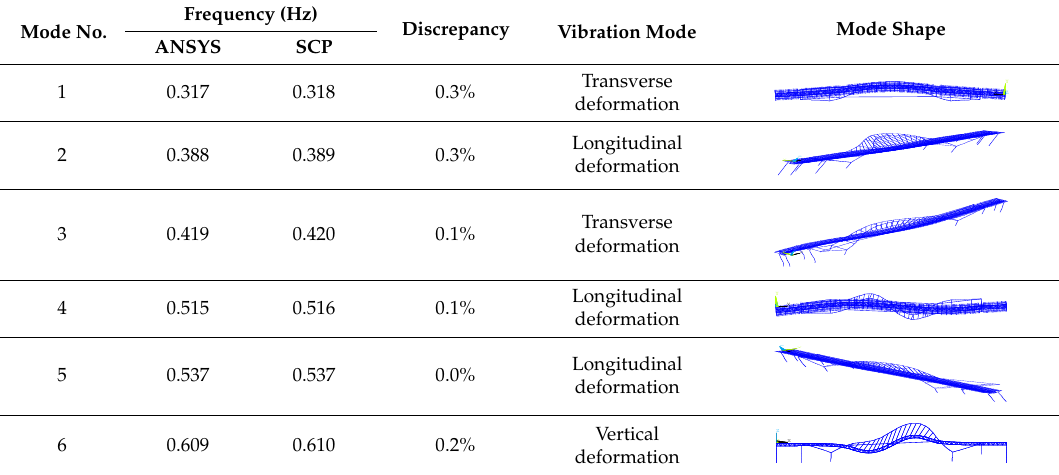
Table 4. The free frequency and mode shapes.